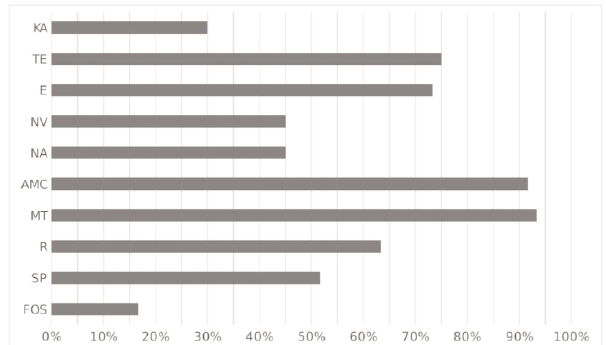
Fig. 5 - Estimation of resistance of PGPR strains to